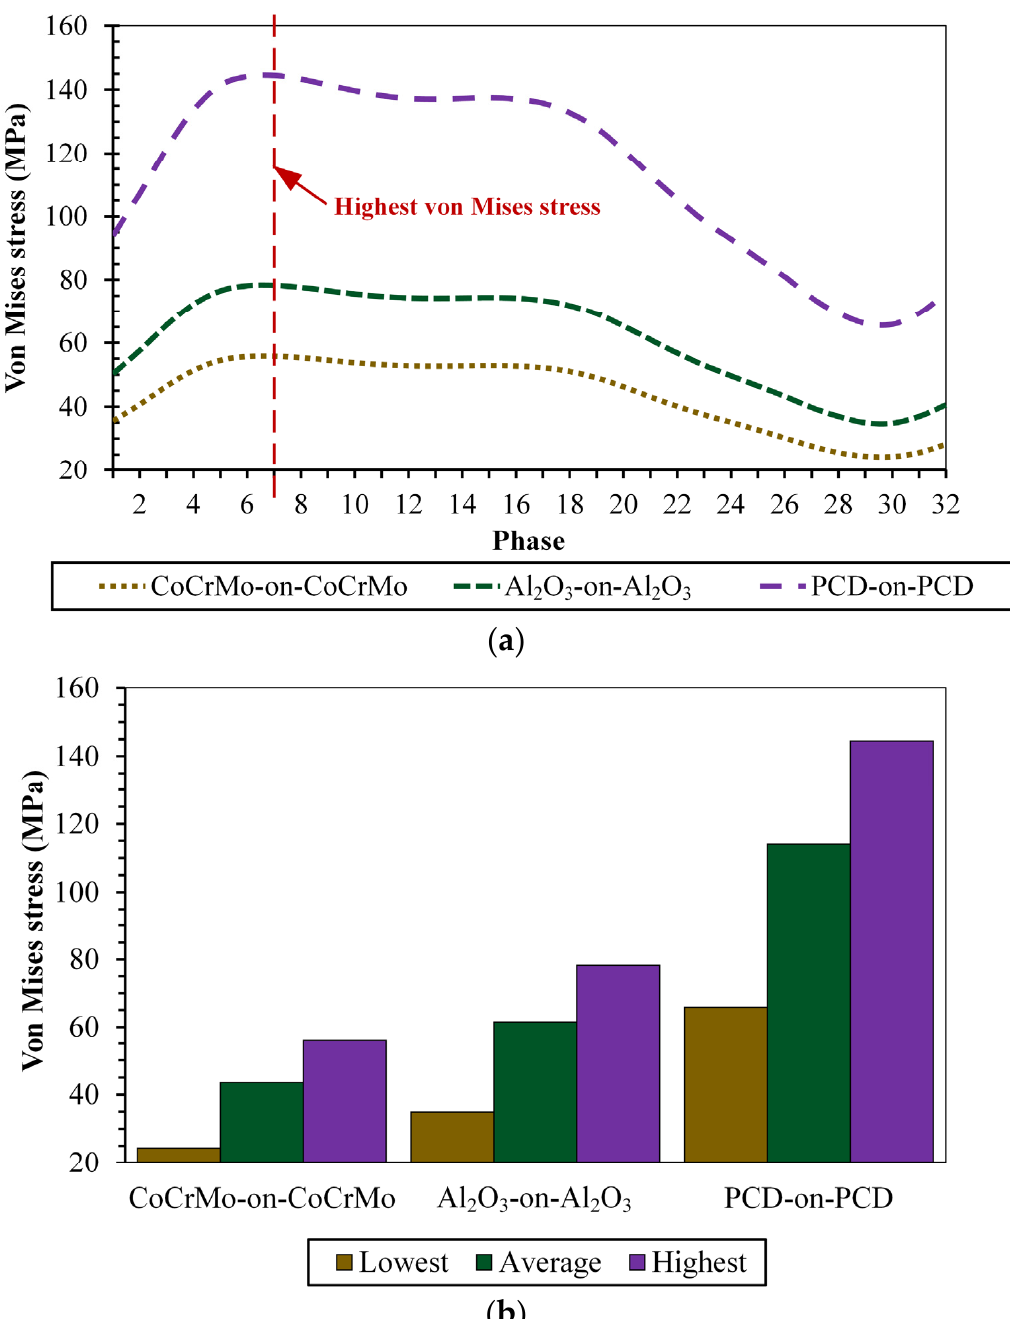
Figure 6. Von Mises stress of hard-on-hard bearings: ( a ) maximum value in full 32 phases of gait loading and ( b ) lowest, average, and highest value.